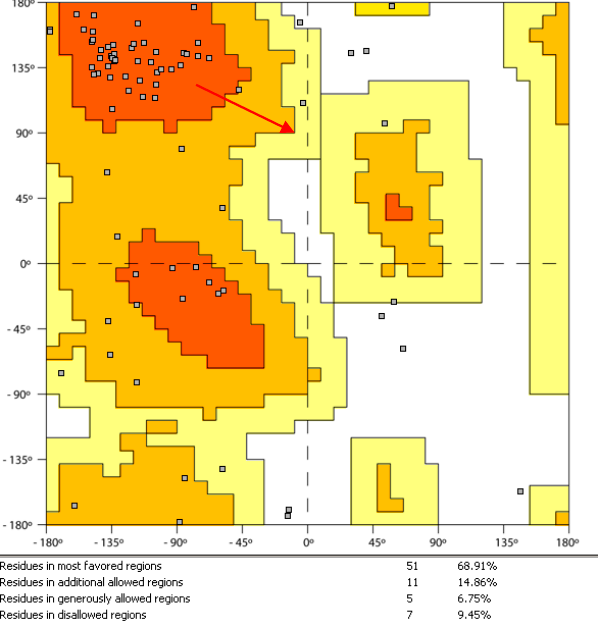
Figure 5. Ramachandran plot of the protein-ligand complex conformation at the end of 60 ns.